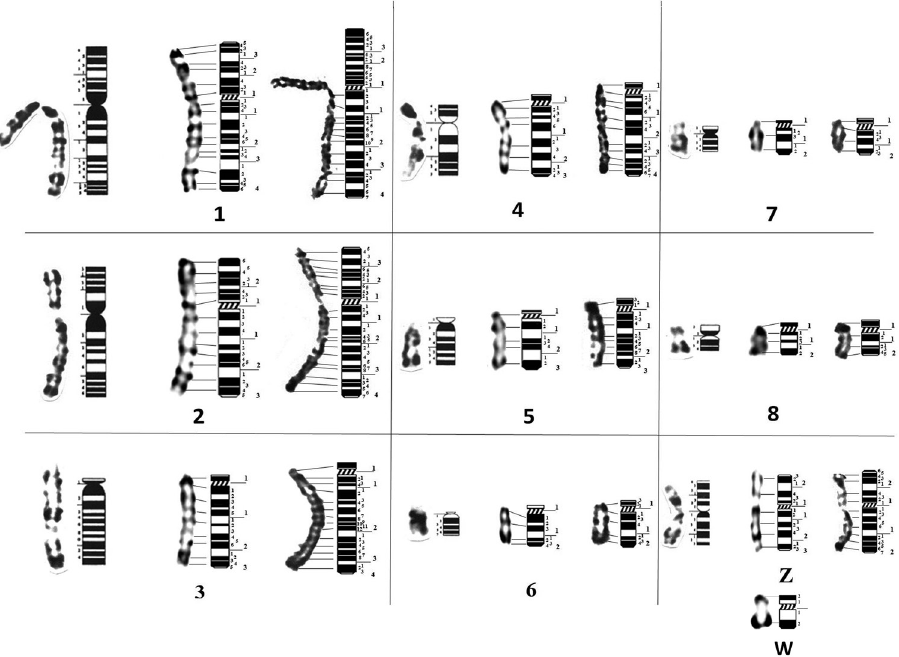
Figure 5. RBG and RHG partial ideograms of (from left to right) G. domesticus (Ladjali-Mohammedi et al. 1999), A. barbara and A. chukar. W chromosome is represented only in A.barbara. Horizontal traits indicate correspondence of positive bands between chromosomes and ideograms. Along ideograms: Large numbers indicate regions, smallest numbers indicate positive and negative